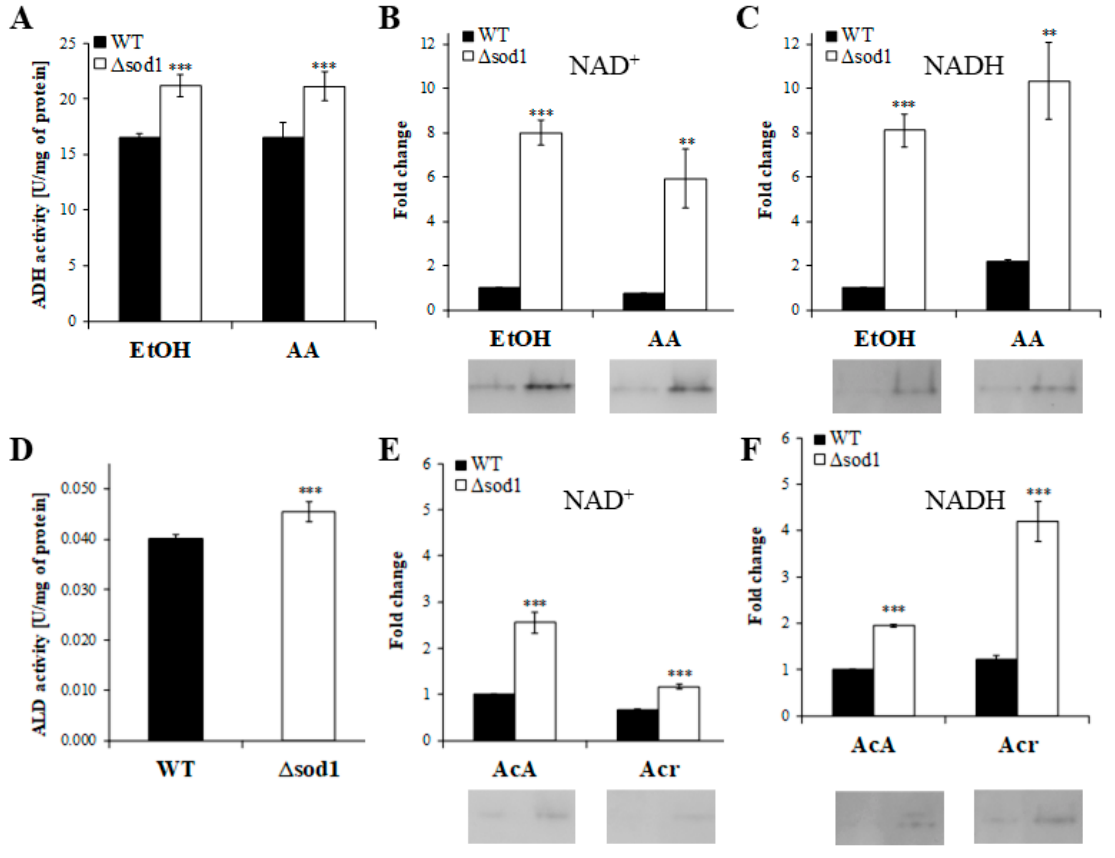
Figure 2. Activity of alcohol dehydrogenase (ADH) and aldehyde dehydrogenase (ALD) in the whole-cell protein extracts prepared for the wild-type (WT) strain and Δ sod1 mutant. ADH activity was determined by measuring the rate of NAD + reduction at 340 nm with ethanol (EtOH) and allyl alcohol (AA) ( A ) and by staining in the gel after native PAGE electrophoresis with ethanol (EtOH) and allyl alcohol (AA) as substrates as well as with NAD + ( B ) and NADH ( C ) as reaction cofactors. ALD activity was determined with 6-methoxy-2-naphthaldehyde as a substrate in the presence of NAD + ( D ). Fluorescence signal increase was recorded at λ ex = 310 nm and λ em = 360 nm. ALD activity was determined by also staining in the gel after native PAGE electrophoresis with acetaldehyde (AcA) and acrolein (Acr) as substrates as well as with NAD + ( E ) and NADH ( F ) as reaction cofactors. The results are presented as mean ± SD from four independent experiments in each case. ** p < 0.01, *** p < 0.001 as compared to the results for the WT strain. 2.3. Changes in the Expression of Genes Encoding Alcohol and Aldehyde Dehydrogenases do Not Affect the Content of These Enzymes in the Δ sod1 Mutant Cells In the yeast S. cerevisiae, there are three genes coding for cytosolic isoenzymes, both in the case of alcohol dehydrogenase ( ADH1 , ADH2 , ADH5 ) and aldehyde dehydrogenase ( ALD2 , ALD3 , ALD6 ). The level of expression for individual genes using the −ΔΔ C T method for comparison with the WT strain and the Δ sod1 mutant was calculated (Figure 3A–F). It was shown that the expression of ADH1 , ALD2, and ALD3 genes was down- regulated in the Δ sod1 mutant (Figure 3A,D,E). The level of expression was approx. 1.4, 1.9, and 4.7 times lower for the case of ADH1 , ALD2, and ALD3 genes, respectively (Figure 3A,D,E). There was no difference in the expression of ADH5 and ALD6 genes between both tested strains (Figure 3C,F). In turn, the expression of the ADH2 gene was up-regu- lated in the Δ sod1 mutant in comparison to the WT strain (Figure 3B). Furthermore, the relative expression of these genes ( −Δ C T ) in the same strains was calculated (Figure S1). It can be seen that, during the growth of the yeast in the medium with glucose, the highest level of expression was determined for the case of ADH1 and ALD6 genes. However, the